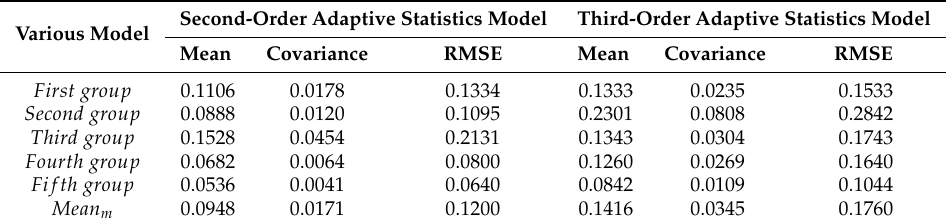
Table 5. Mean, covariance and RMSE of the last 5000 points derived by the adaptive statistics model.